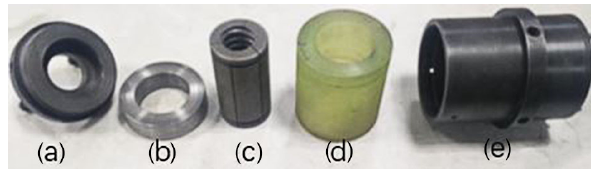
Figure 2. Main parts of the lapping tool: (a) the threaded end cover; (b) the spacer; (c) the lapping nut; (d) the polyurethane outer ring; (e) the